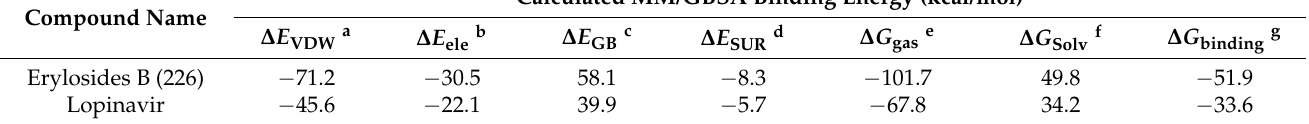
Table 2. Components of the MM/GBSA binding energies for erylosides B (226)- and lopinavir-M pro complexes as determined by MD simulation at 100 ns.